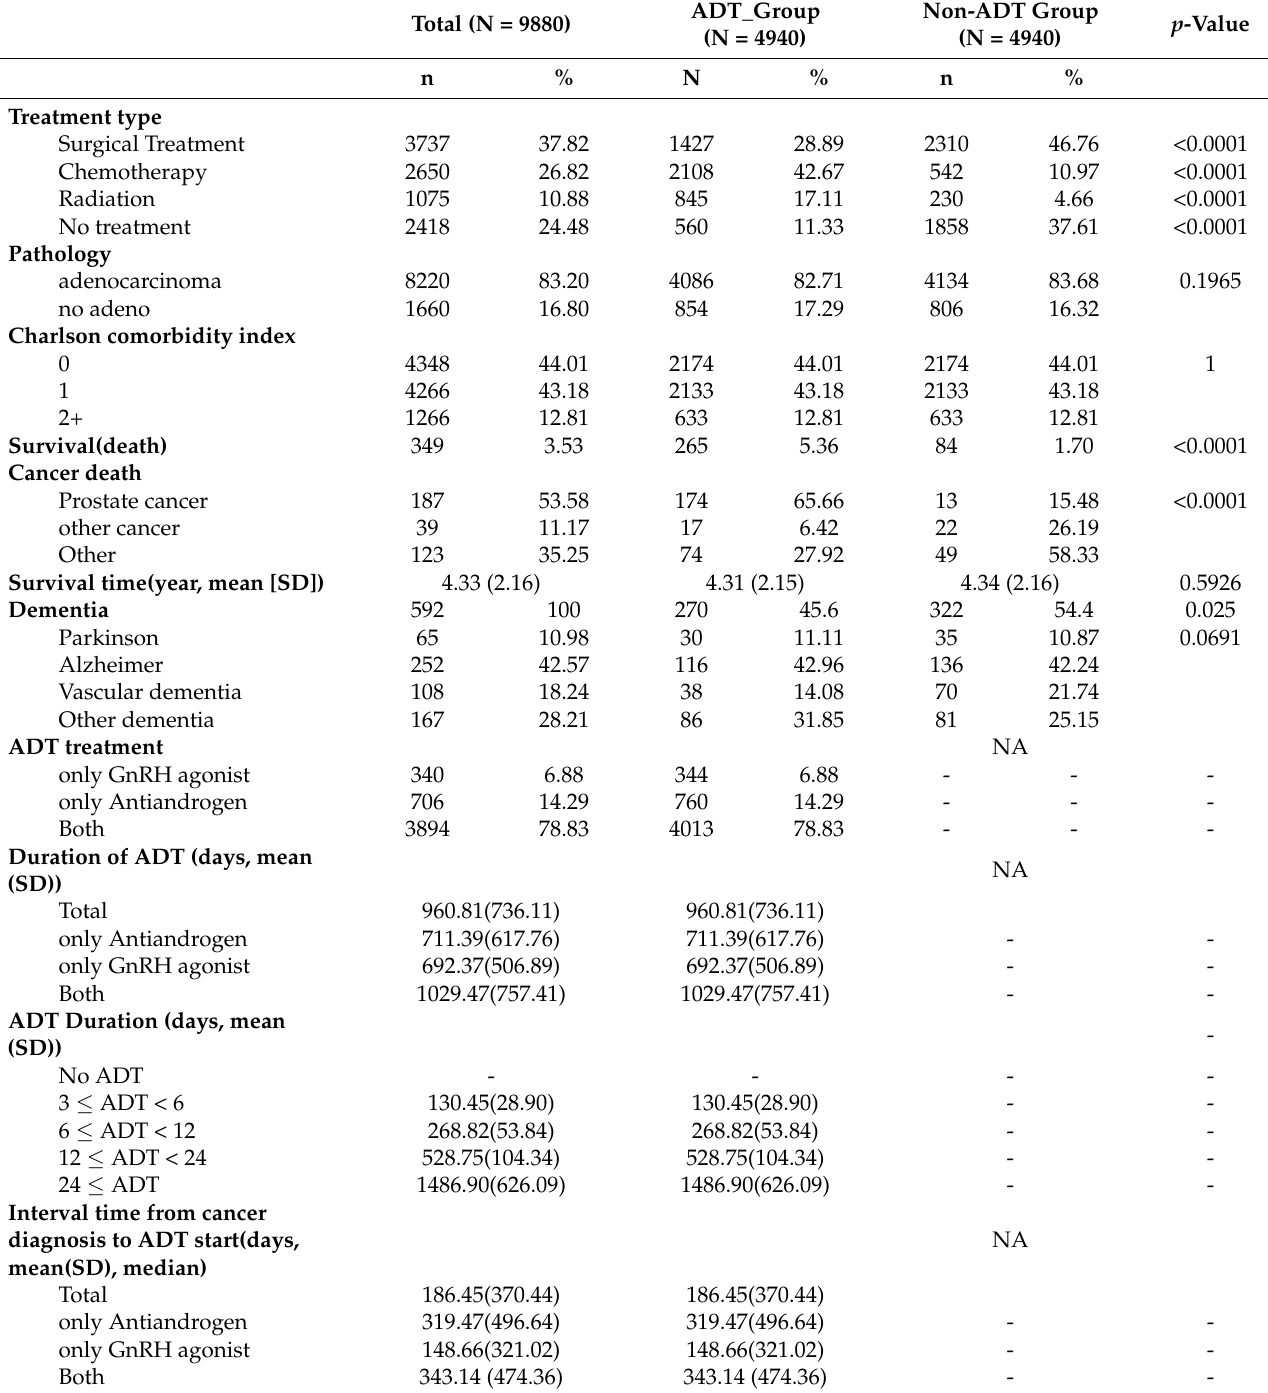
The 1:1 matched comparative results between ADT and non-ADT groups demon- strated that the overall dementia incidence was significantly different (ADT, N = 270 [45.6%] vs. non-ADT, N = 322 [54.4%], p = 0.025), whereas the incidences of each individual